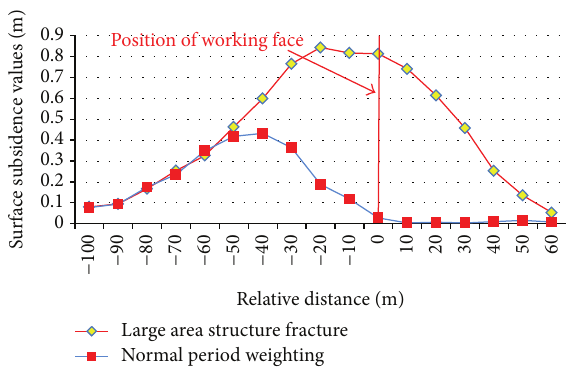
Figure 3: Surface subsidence values one day after two kinds of roof weighting.